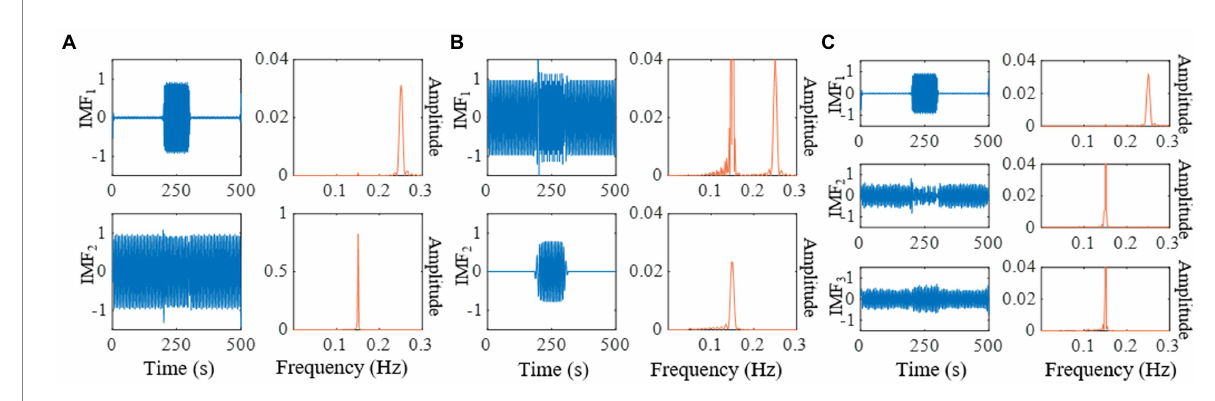
FIGURE 3 Decomposition of the synthetic signal by IMEMD. (A) The 0 ξ =1.5. (B) The 0 ξ =0.1. (C) The 0 ξ =3.